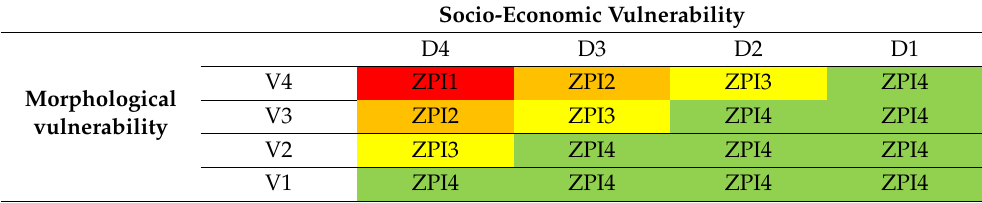
Table 4. Levels of flooding risk. The colours indicated the levels of flooding risk with red indicating very high flooding risk and green low flooding